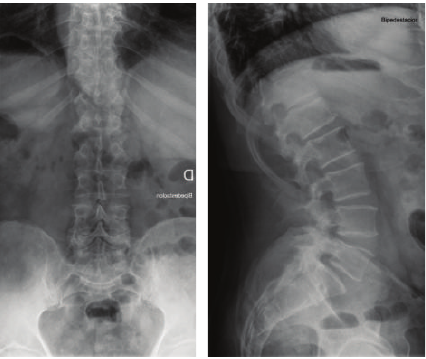
Figure 2: Preoperative anteroposterior and sagittal X-ray. Spondy- lolisthesis L5-S1 grade I.